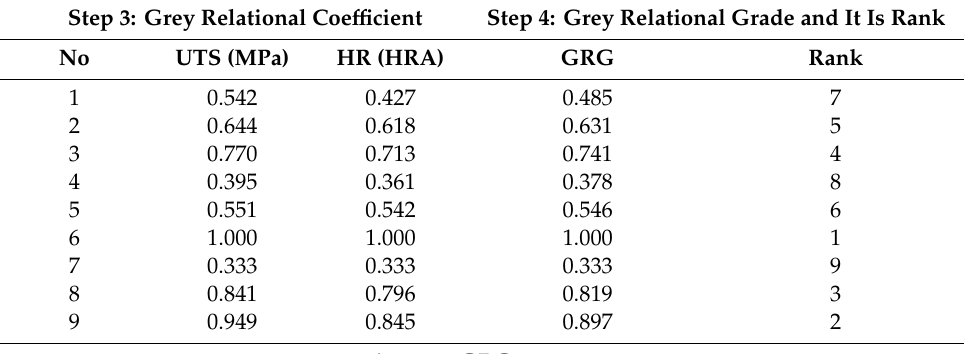
Table 15. Results of Grey relational coe ffi cient and Grey relational grade with its